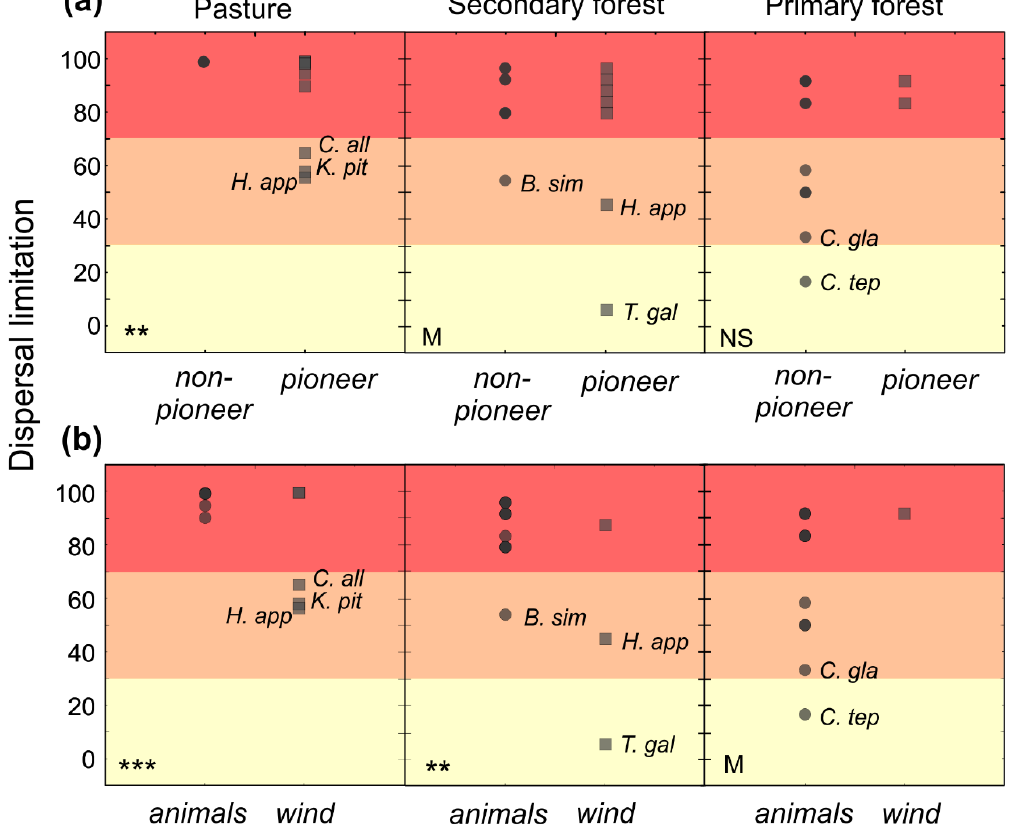
Figure 1. Plotted raw data of dispersal limitation by: ( a ) habitat and life history; and ( b ) habitat and dispersal mode. Each circle or square represents one of the 33 tropical tree species. The generalized linear models (GLM) showed significance for the interaction of: ( a ) habitat and life history; and ( b ) habitat and dispersal mode. Statistical significance between ( a ) pioneer and non-pioneer species and ( b ) animal- and wind-dispersed species within each habitat are indicated with asterisks (** p < 0.01, *** p < 0.001), M for marginal significance and NS for non-significant. Limitation from 0% to 33% was classified as low (yellow), from 34% to 66% as intermediate (orange) and from 67% to 100% as high (red).